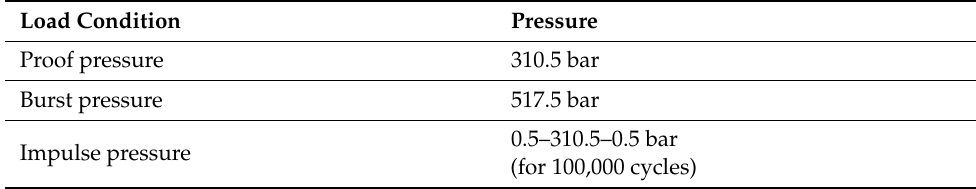
Table 4. Hydraulic load conditions applied